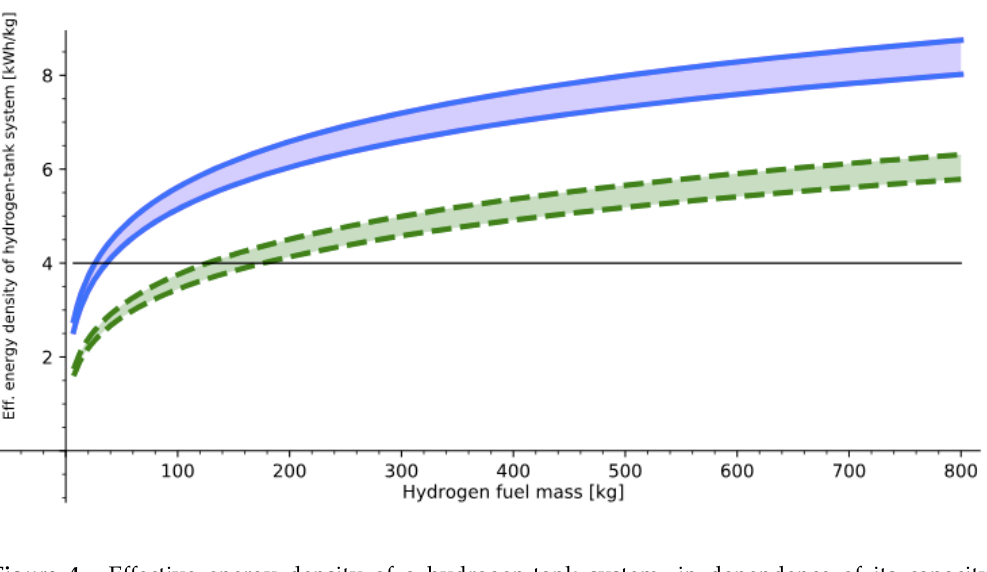
Figure 4. Effective energy density of a hydrogen-tank system, in dependence of its capacity for: (blue area, full-line) liquid hydrogen; and (green area, dashed-line) compressed hydrogen. For comparison, the black (thin) line presents the effective energy density of